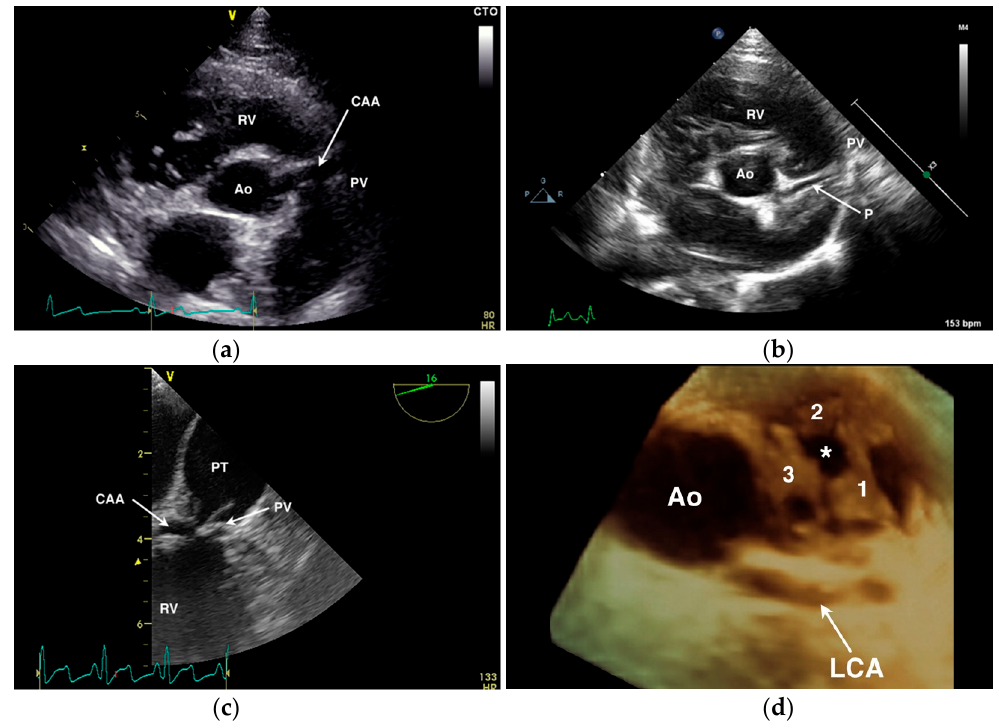
Figure 6. Echocardiographic examples of anomalous coronary artery origin or course. ( a ) Transthoracic short-axis image of the aortic root (Ao) showing a large single right coronary ostium with an anomalous coronary artery (CAA) traversing over the pulmonary valve (PV) annulus. RV = right ventricle. ( b ) Transthoracic short-axis image of the aortic root (Ao) from a dog with normal coronary anatomy demonstrating a normal paraconal interventricular branch (P) that appears to cross cranial to the PV annulus. ( c ) Transesophageal long-axis image of the RV outflow tract of a dog with a CAA seen crossing the PV at the base of the pulmonary trunk (PT). ( d ) Three-dimensional transesophageal image of the Ao from a dog with single right coronary ostium and a prepulmonary left coronary artery (LCA) showing the position of the LCA encircling the three PV leaflets (labeled 1 through 3) and the stenotic PV orifice (*).